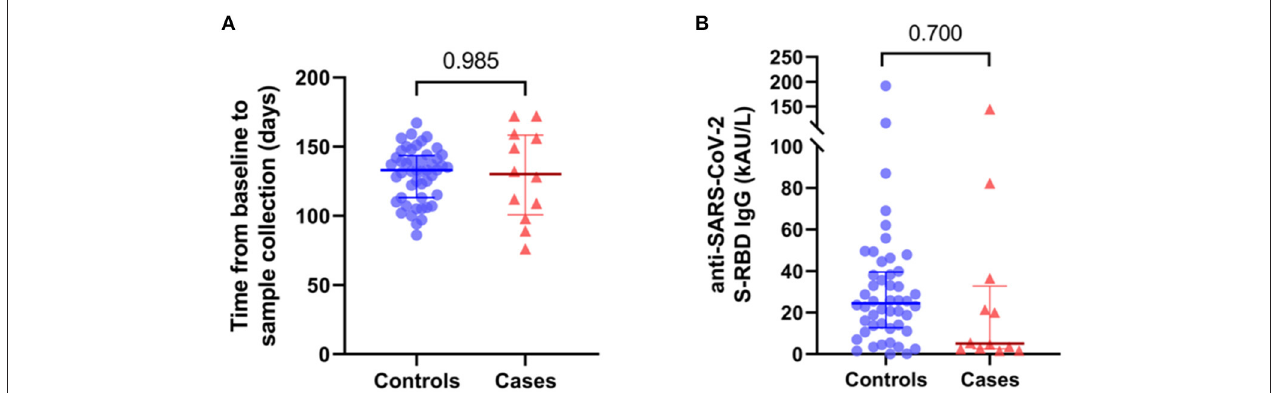
FIGURE 1 | (A) Time(days) from baseline to sera collection of controls and cases. (B) IgG S-RBD title (kAU/L) of controls and cases. Median and IQR are